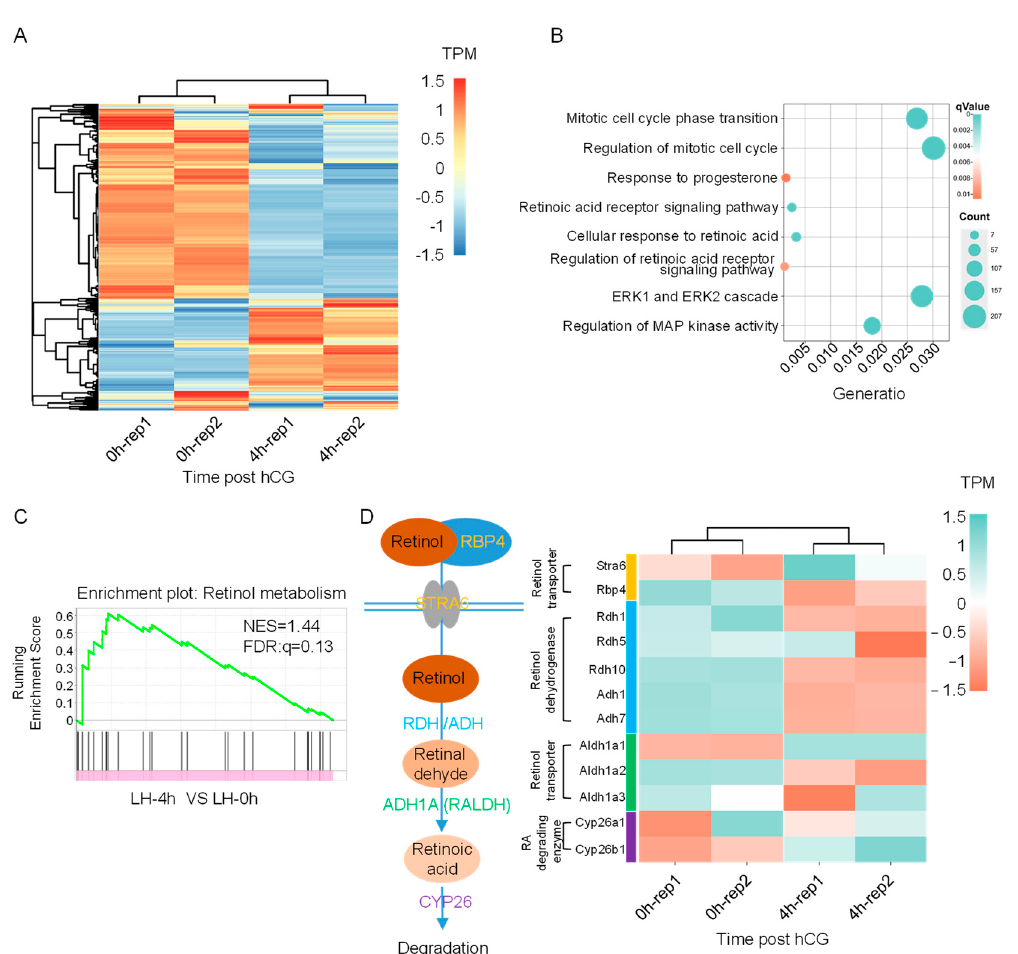
Figure 2. LH activates RA synthetic and metabolic pathways in preovulatory MGCs. Data are presented based on the reanalysis of previously published transcriptome data that present rapid effects of LH on gene expression in the MGCs of mouse preovulatory follicles. ( A ) Heat map of the hierarchical clustering results of DEGs in response to LH surge. ( B ) Bubble plot of the enriched GO terms of DEGs in response to LH. The X -axis in the bubble plot represents GeneRatio, while the y -axis indicates different biological processes. ( C ) GSEA analysis showing enrichment of Retinol metabolism, Normalized enrichment score (NES) and false discovery rate (FDR) q value are shown. ( D ) Schematic illustration of the retinoic acid metabolic pathway (Left panel) and the heat map of relevant genes in response to LH